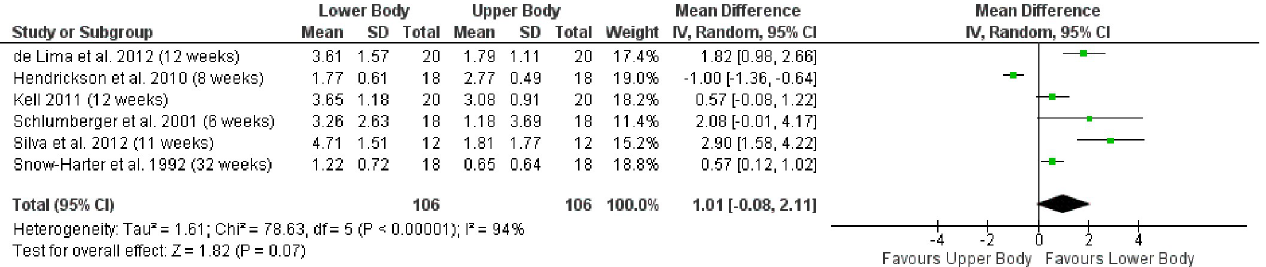
PLOS ONE | https://doi.org/10.1371/journal.pone.0284216 April 13,